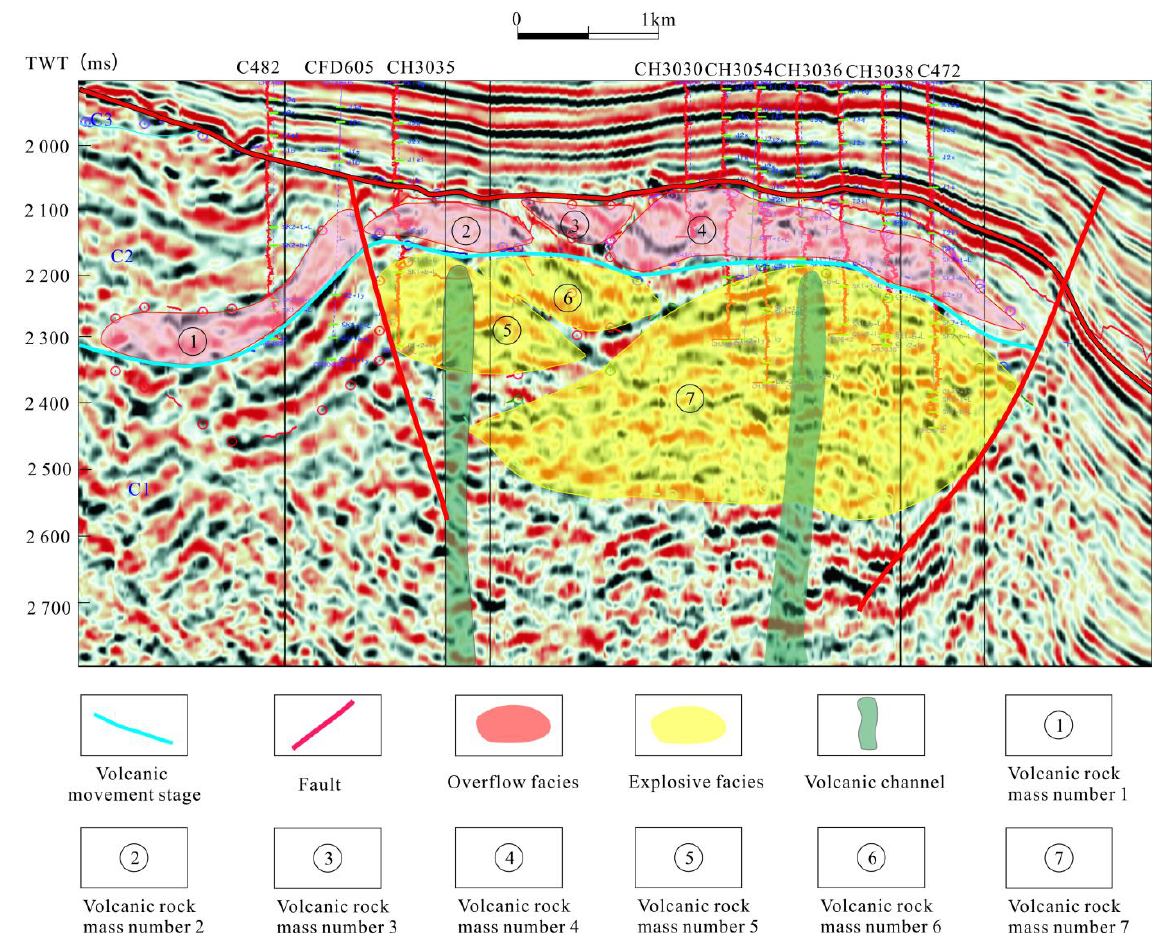
Figure 3. Distribution characteristics of volcanic rock bodies of the Carboniferous volcanic reservoirs in the Chepaizi Uplift.